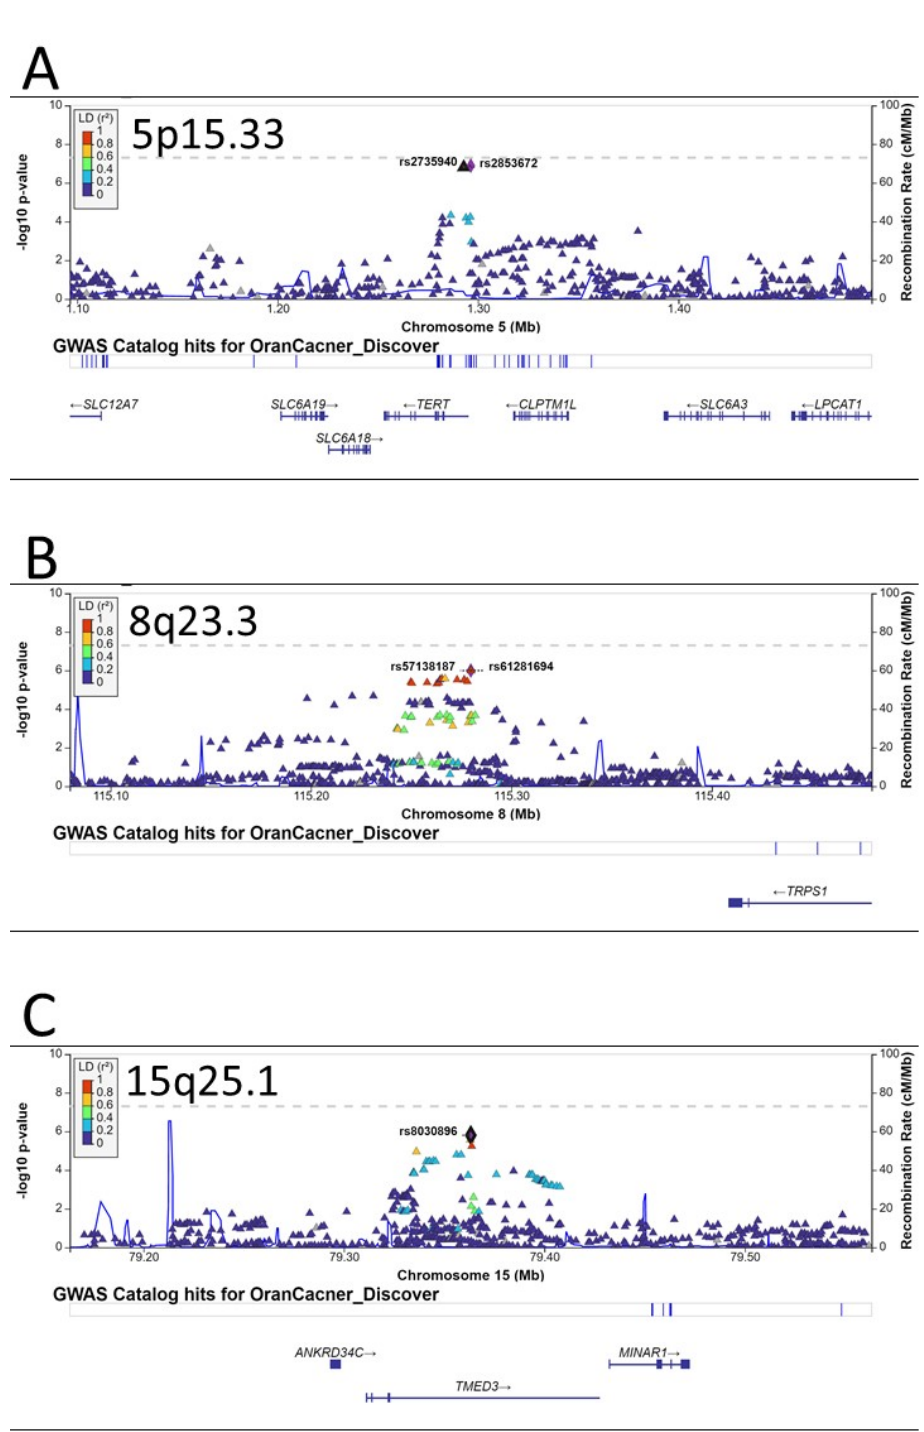
Figure 3. Regional plots of associations for regions of 5p15.33 ( A ), 8q23.3 ( B ), and 15q25.1 ( C ). The y -axis presents the − log 10 p -values of the SNPs and the x -axis presents the corresponding chromosomal position of each SNP. The genomic locations of genes within the regions were annotated from the UCSC Genome Browser.